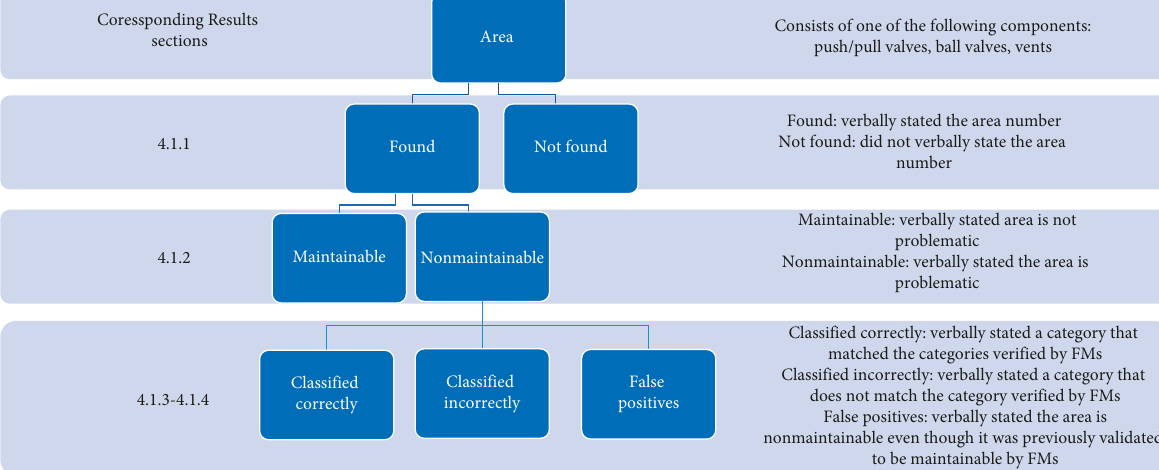
Figure 4: Steps for analyzing design review